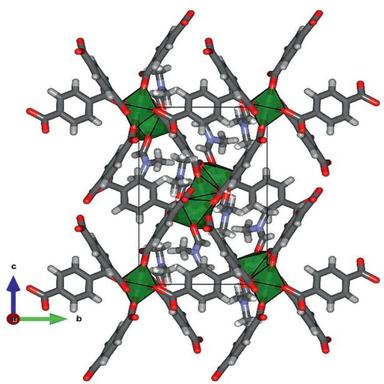
Structure of n View along the a axis of the coordination network structure.